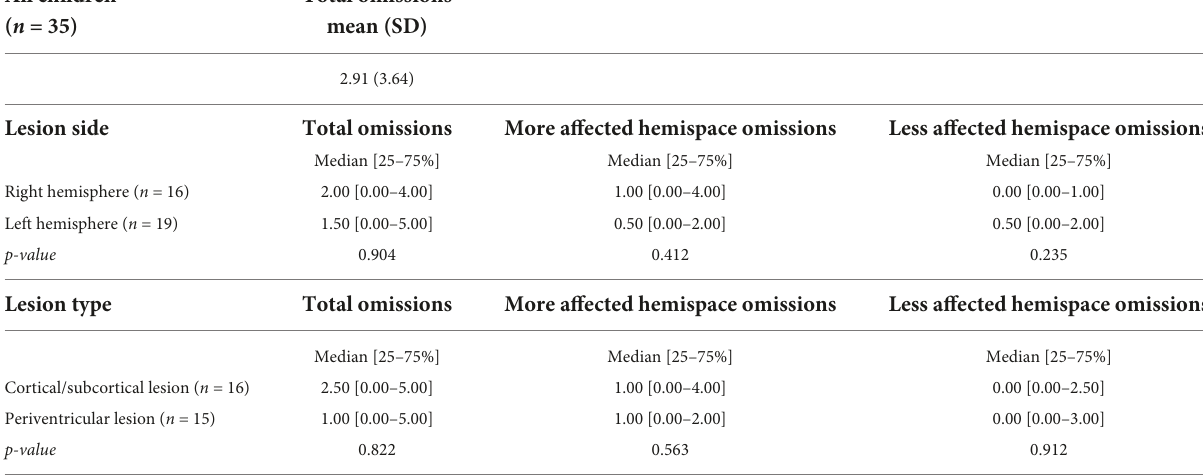
TABLE 2 Star cancelation scores.